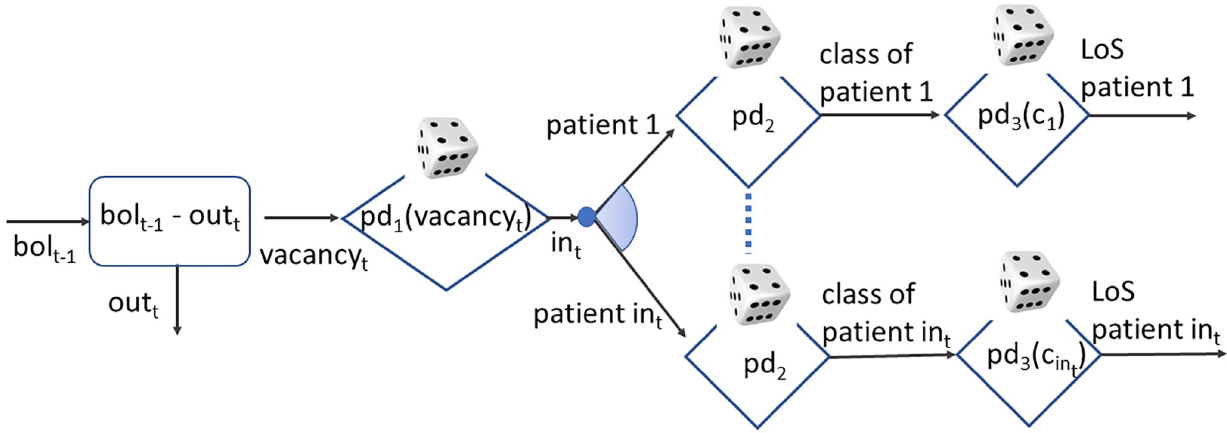
Fig 1. Flow chart of the generation process of ward bed occupancy.